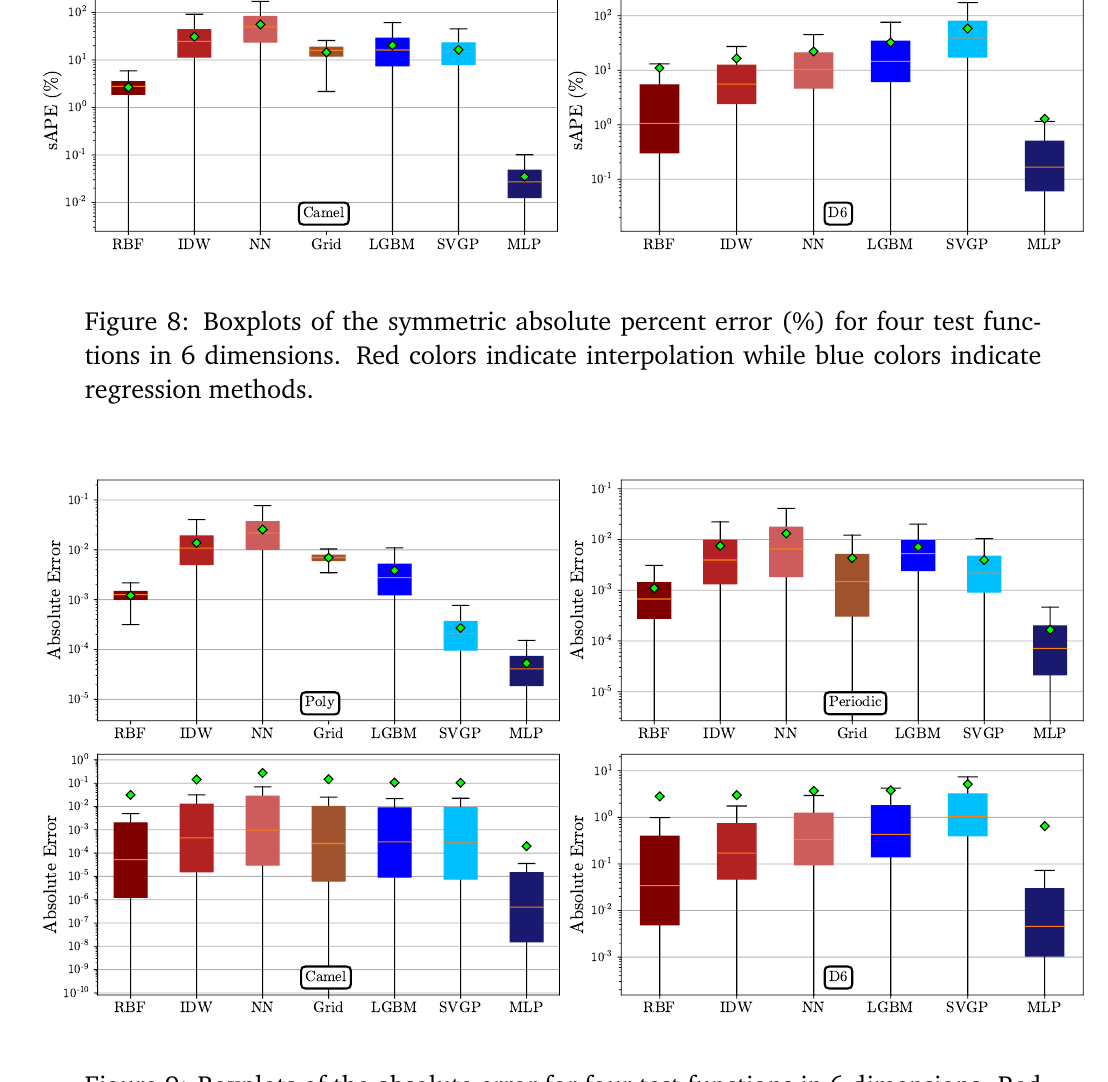
Figure 9: Boxplots of the absolute error for four test functions in 6 dimensions. Red colors indicate interpolation while blue colors indicate regression